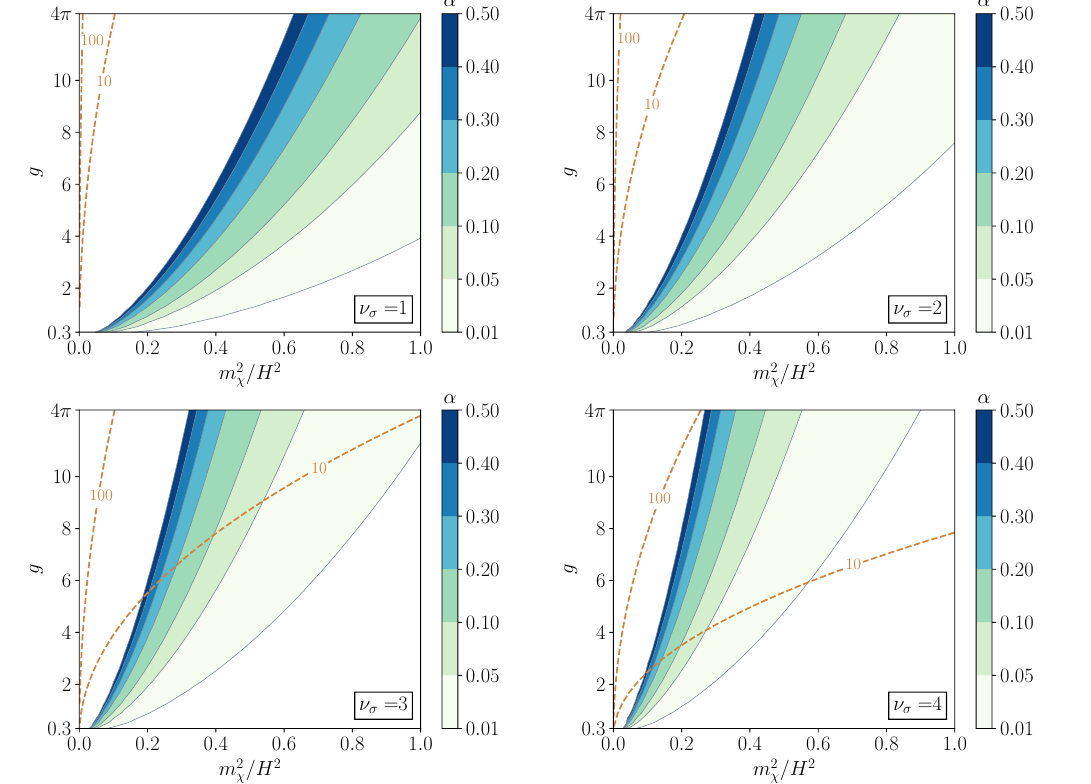
Figure 3 . Dependence of the signal strength α (defined in eq. (3.15), which alters the signal scaling as in eq. (3.16)) on m 2 and g for fixed m σ with ν σ = 1 , 2, 3, 4. The range of α that is plotted is χ approximately the range that we expect to be observable in future 21 cm observations, as discussed in section 4. The dashed brown contours are where the calculable 1-loop correction eq. (3.17) to δm 2 is 10 and 100 times the physical value, respectively. These contours are intended to give a very χ rough guide to which regions of parameter space are necessarily fine